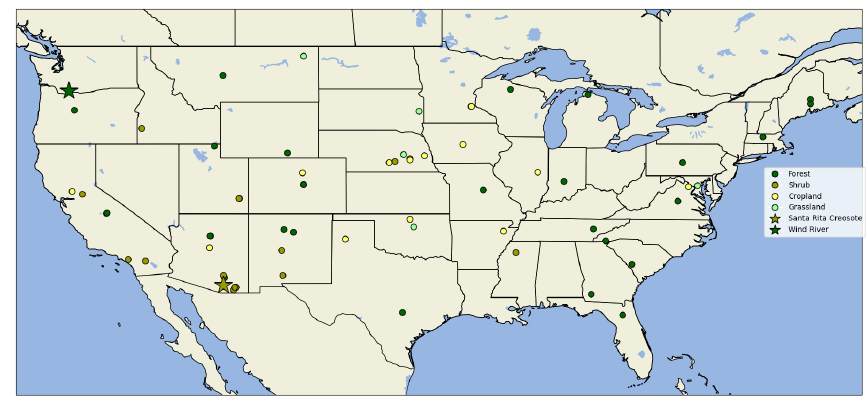
Figure 4. Map showing the location of CRNS sites from the COSMOS network across continental USA (CONUS). The colours are repre- sentative of the land cover types obtained from the ESA CCI global database, and the stars highlight the location of the two sites processed above (i.e. Santa Rita Creosote and Wind River).